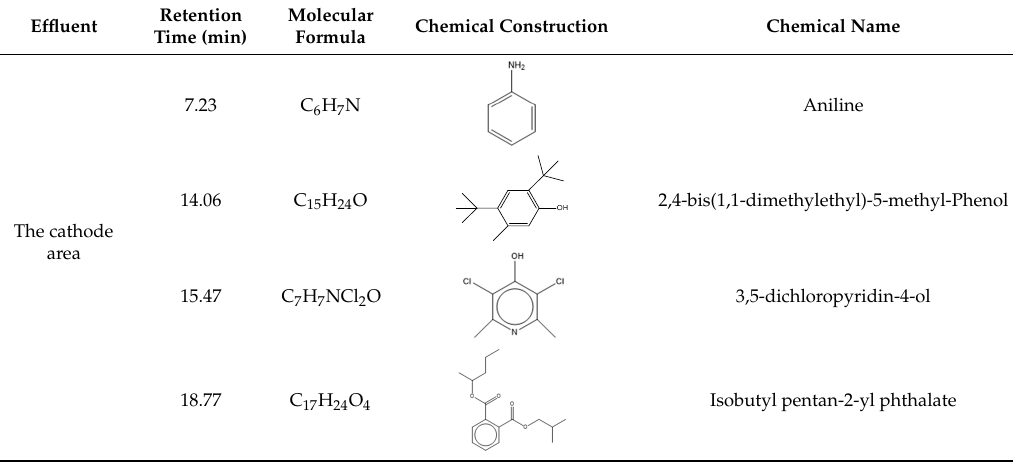
Figure 5. The chromatogram of the effluent ( A ) the cathode area; ( B ) the top of the granular activated carbon (GAC) layer and ( C ) the anode area. Table 1. Gas chromatography-mass spectrometry (GC-MS) analysis results of the effluent from the cathode area, the top of the activated carbon layer and the anode area.